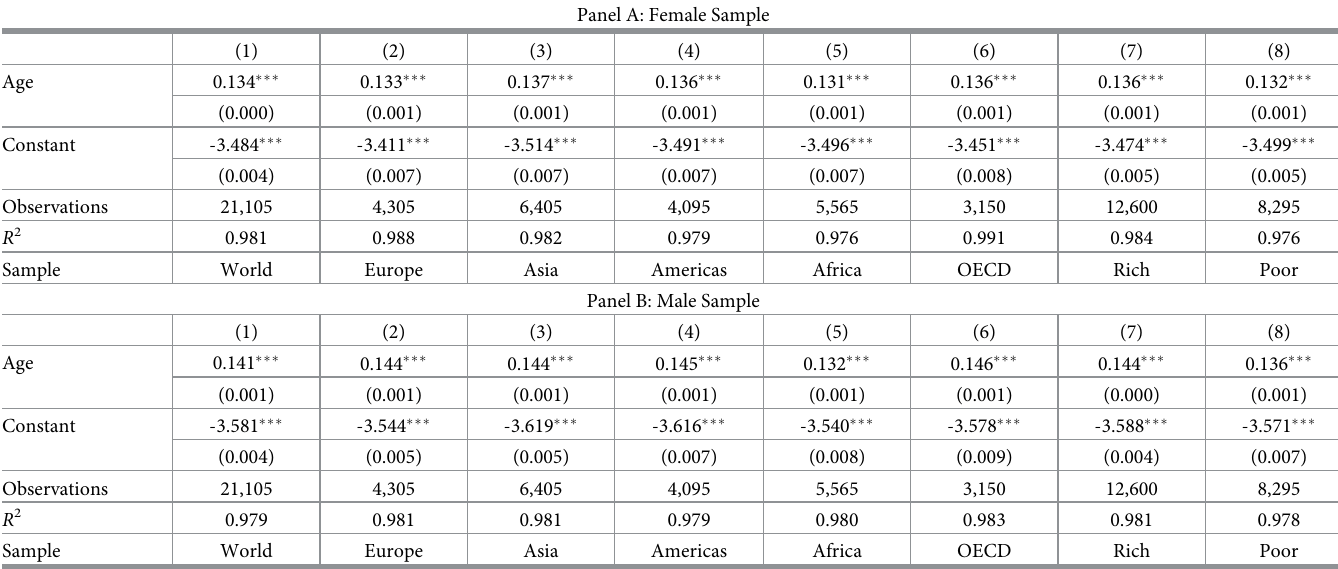
Table 1. Estimated growth rate of deficits.